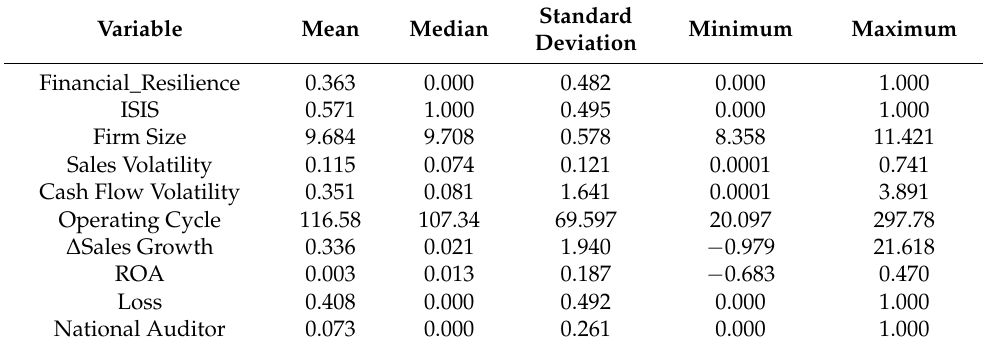
Table 1. The Descriptive statistics of research variables.